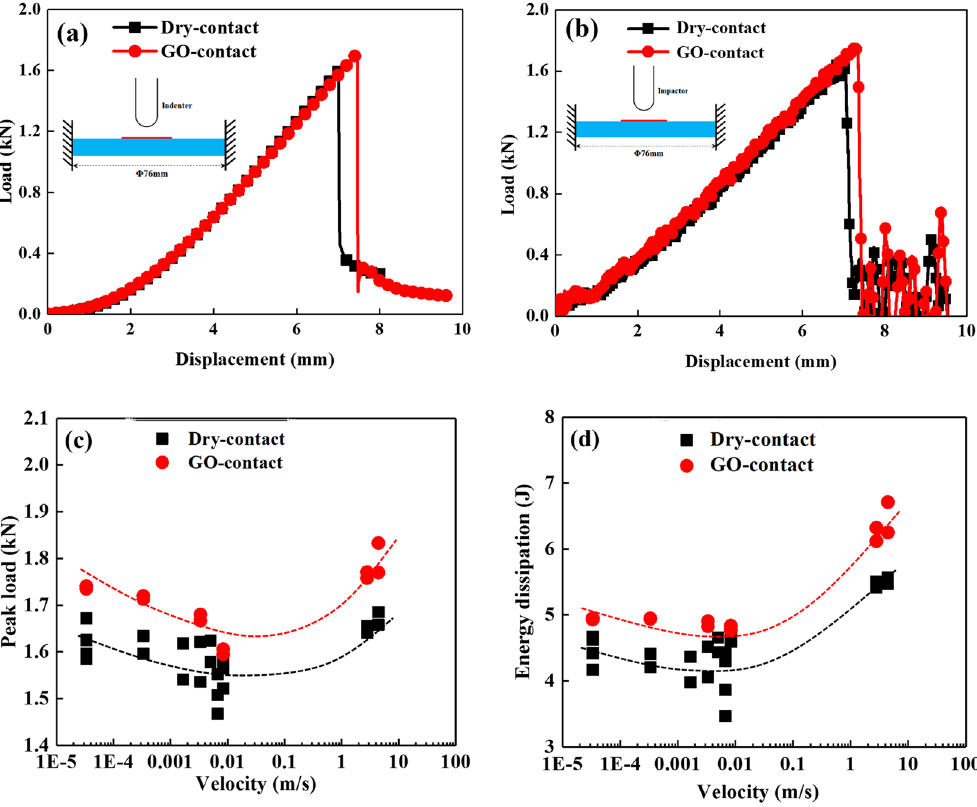
Figure 1. Penetration load and energy of a single-layer aluminum sheet coated with a GO solution: ( a ) load- displacement curves under 3.33 × 10 − 4 m/s (quasi-static) loading, ( b ) load-displacement curves under 2.79 m/s impact loading, ( c ) peak-load and ( d ) energy dissipation as a function of indentation